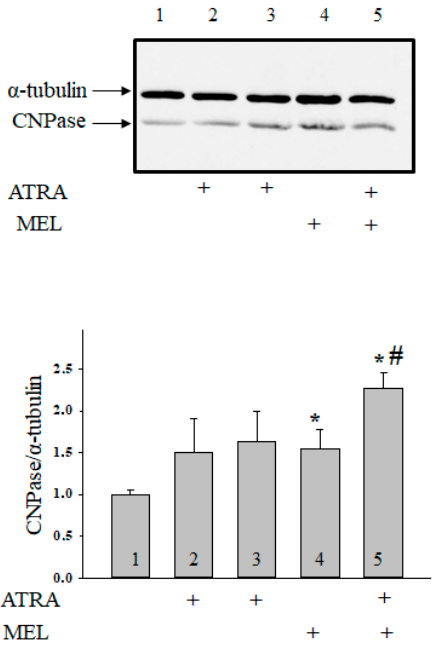
Figure 5. Combined effect of MEL and ATRA on the level of CNPase in HL-60 cells. Cells were seeded in a 96-well plate at a density of 5 × 10 3 cells per well and treated with 1 µ M ATRA (column 2), and 10 nM ATRA (columns 3) and 1 mM MEL (column 4), and MEL in combination with 10 nM ATRA (column 5); untreated cells (control, column 1). Protein samples were extracted and subjected to Western blot for CNPase detection. The immunodetection of α -tubulin was used as a loading control. Upper part-immunostaining of CNPase and α -tubulin. Lower part-quantitation of immunostaining using computer-assisted densitometry. Bar graphs represent the Bcl-2 level in relative units. The protein level in a cell lysate without any addition was taken to be unity and served as a control. The data are presented as means ± S.D. of five separate experiments. * p < 0.05 significant difference in protein level in comparison with corresponding control, # p < 0.05 significant difference in the protein level compared to the value obtained in the presence of MEL alone.